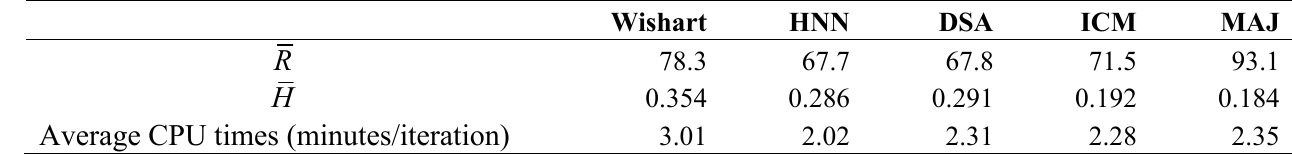
Table 3. Averaged Cluster Separability values ( R ), Homogeneities ( H ) and central processing unit (CPU) times for Wishart, HNN, DSA, ICM and Majority (MAJ) for San Francisco Bay (SFB)